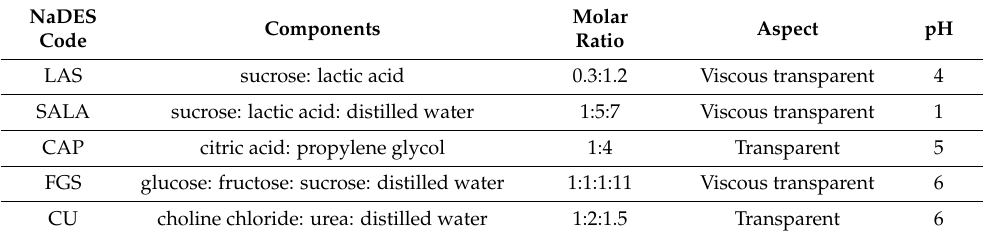
Table 3. Natural deep eutectic solvents (NaDES) used for extraction.